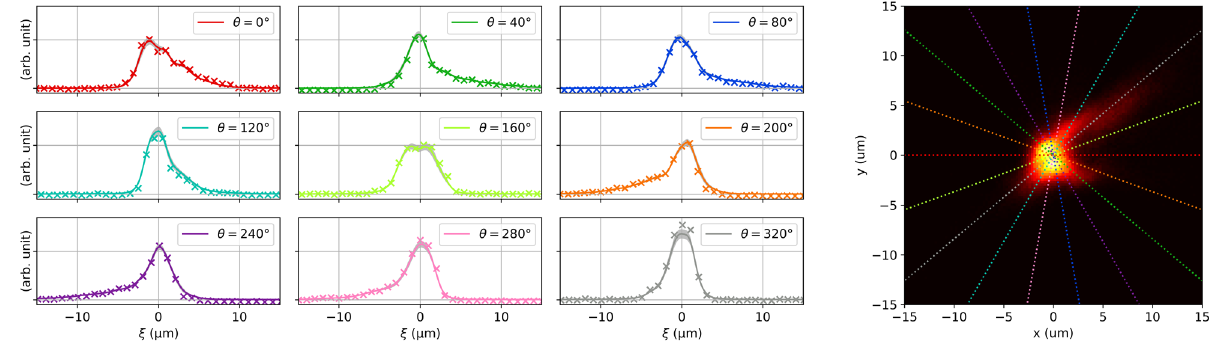
FIG. 8. Tomographic reconstruction of a beam with non-Gaussian tails. The nine measured projections are indicated by crosses in the small nine sub-plots. The reconstruction result is shown in the larger subplot on the right ( x , y profile). The projections of the reconstruction are shown as solid lines in the corresponding subplots. The colors correspond to the different projection angles as indicated by dashed lines in the 2D profile plot on the right. The tomographic reconstruction is able to represent the core and tails of the beam.